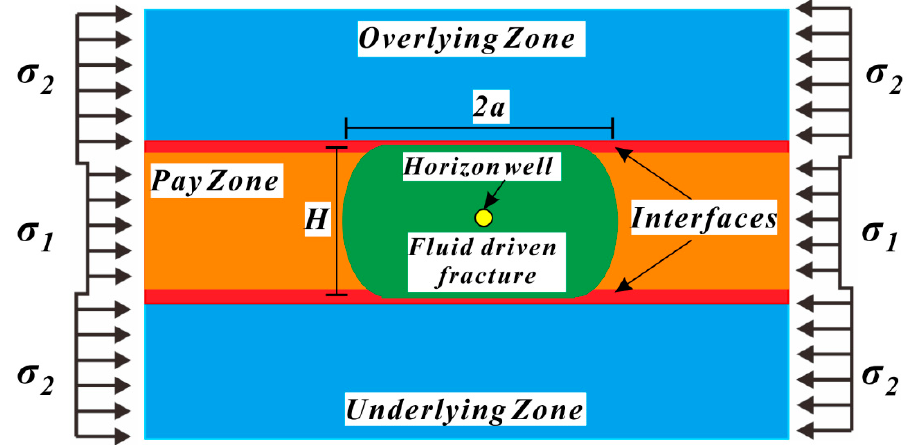
Figure 1. Fracture containment in pay zone.